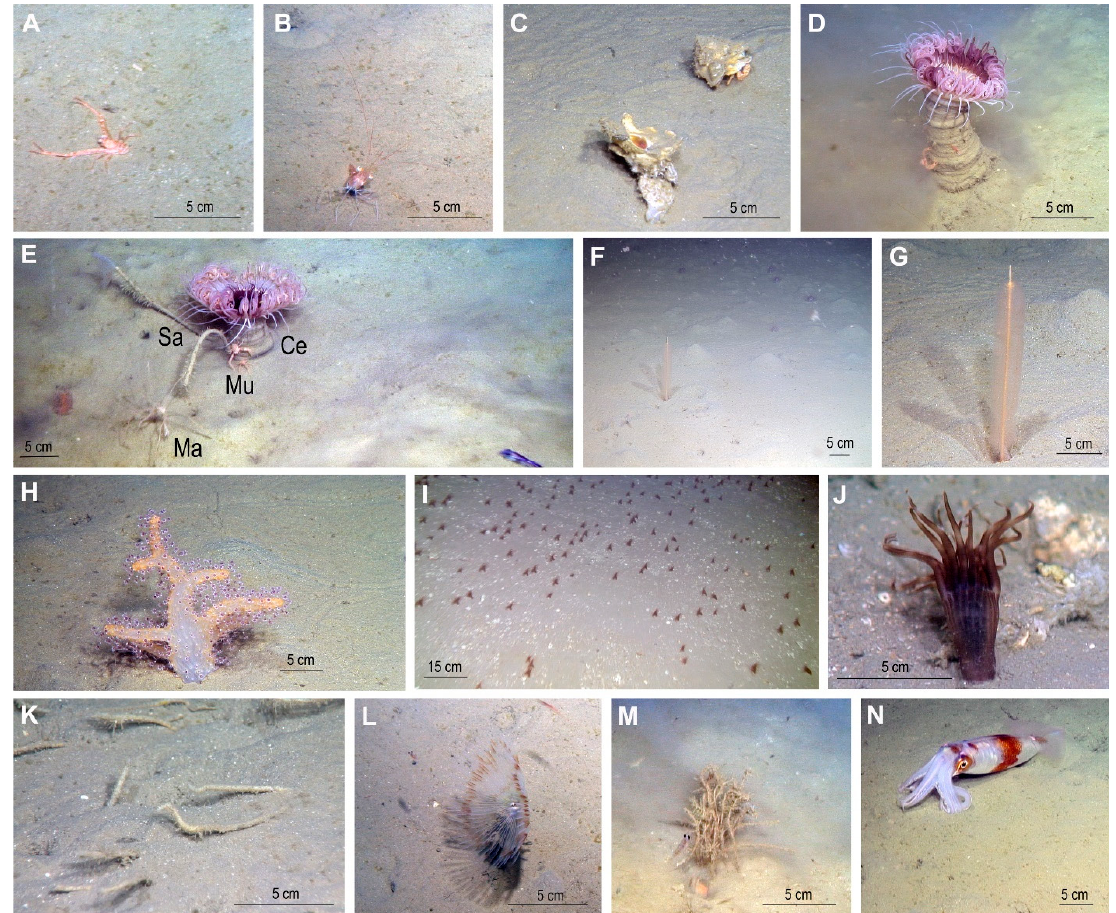
Figure 4. Some examples of present-day bottom sediments and benthic and demersal fauna detected at the Alcántara ( M ), Málaga ( A – E , L , N ) and Aceitunas ( F – K ) carbonate mound fields of the northern Alboran Sea. ( A ) the burrowing decapod Munida sp.; ( B ) the pandalid shrimp Plesionika heterocarpus ; ( C ) Hermit crabs using Xenophora crispa shells; ( D , E ) Cerianthus sp. (Ce) individuals, with one of them located close to two sabellidpolychaete tubes (Sa) and the decapods Munida sp. (Mu) and Macropodia sp. (Ma); ( F , G ) the seapen Virgularia mirabilis ; ( H ) the soft bottom octocoral Alcyonum palmatum ; ( I , J ) an aggregation of an unidentified solitary anthozoan, including a close-up of one individual; ( K , M ) tubes of the polychaete Spiochaetopterus sp. colonized by small hydrozoans; ( L ) the sabellid polychaete Sabella pavonina ; ( N ) the squid Illex coindetii . All underwater images obtained with ROV LIROPUS 2000, Instituto Español de Oceanografía (Spain).